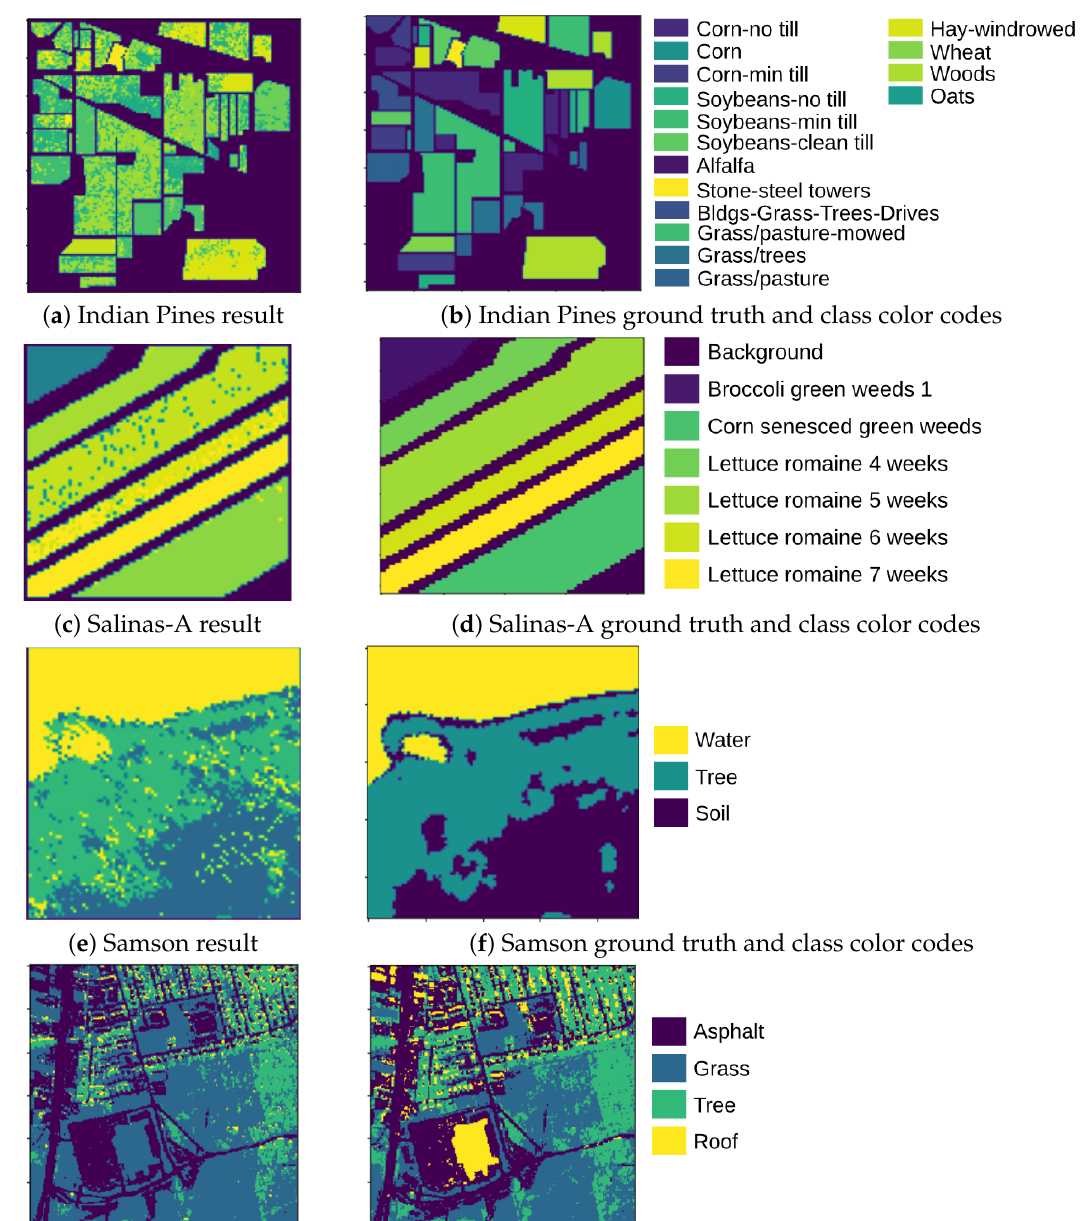
Figure 8. Cluster maps that were obtained from the proposed CLUS-BPT ( left ) and ground reference color codes of classes for Indian Pines, Salinas-A, Samson, and Urban scenes ( right